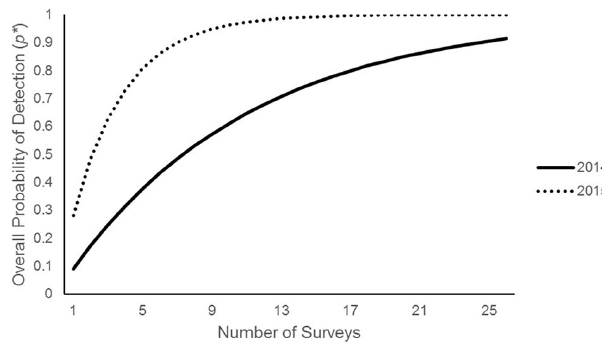
Fig. 2 . Overall probability of detecting Kori Bustards ( Ardeotis kori ) at a site at least once during the set of replicate surveys (represented by p*, given p* = 1-(1-p)^n) during two field seasons in June–July 2014 (p = 0.08) and May–July 2015 (p = 0.26) in the Northern Tuli Game Reserve, Botswana.